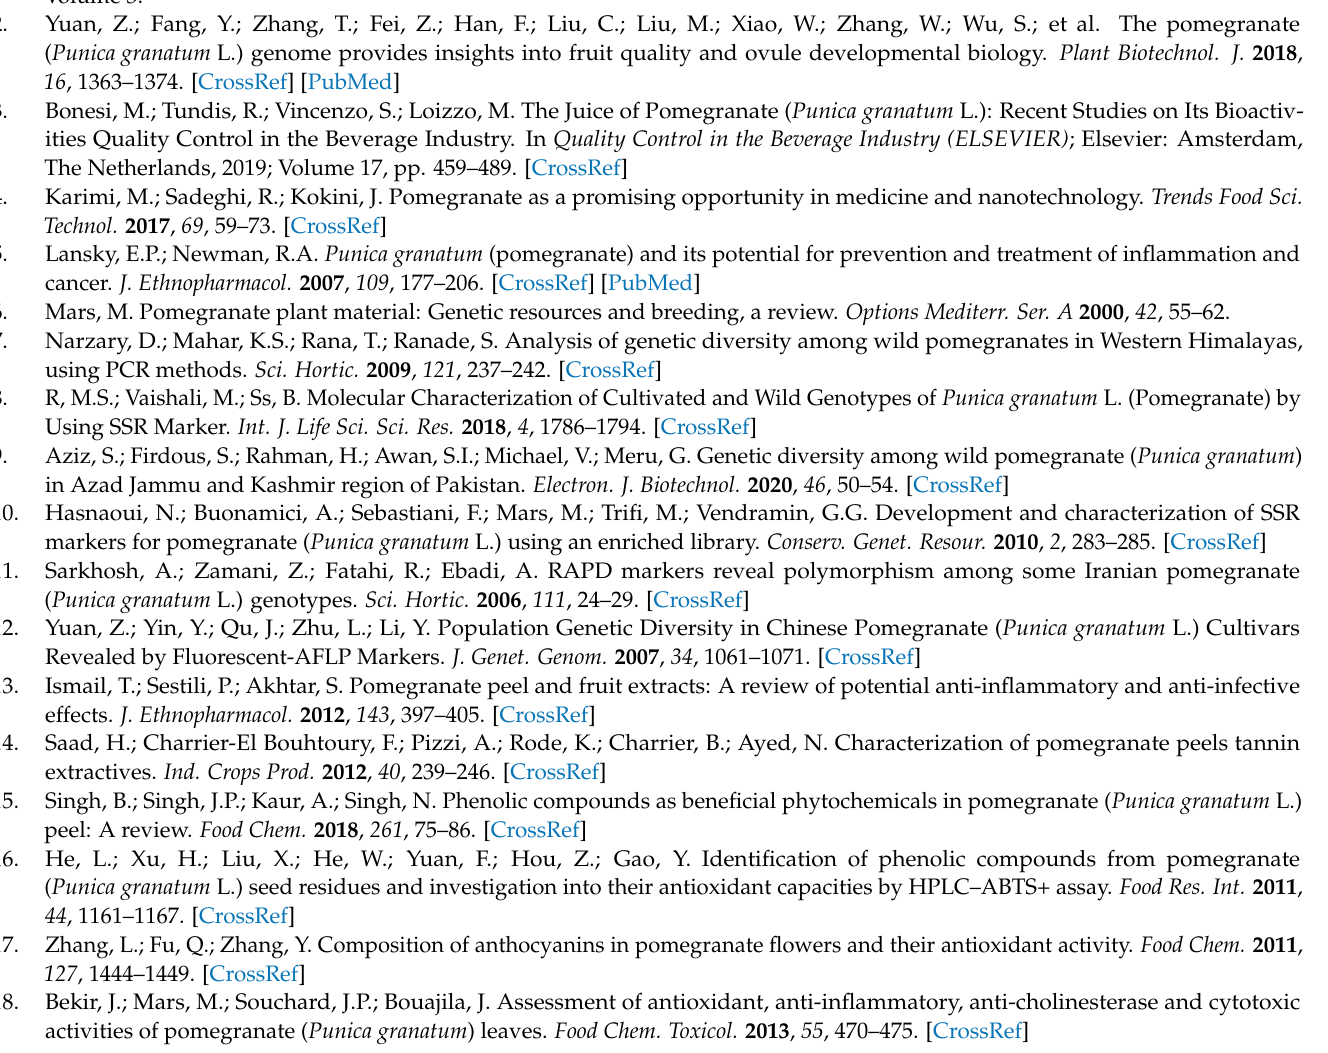
Table S4: LSC, SSC, and IRs (IRA via IRB) regional location, Table S5: Repeat motif, length region, and cpSSR